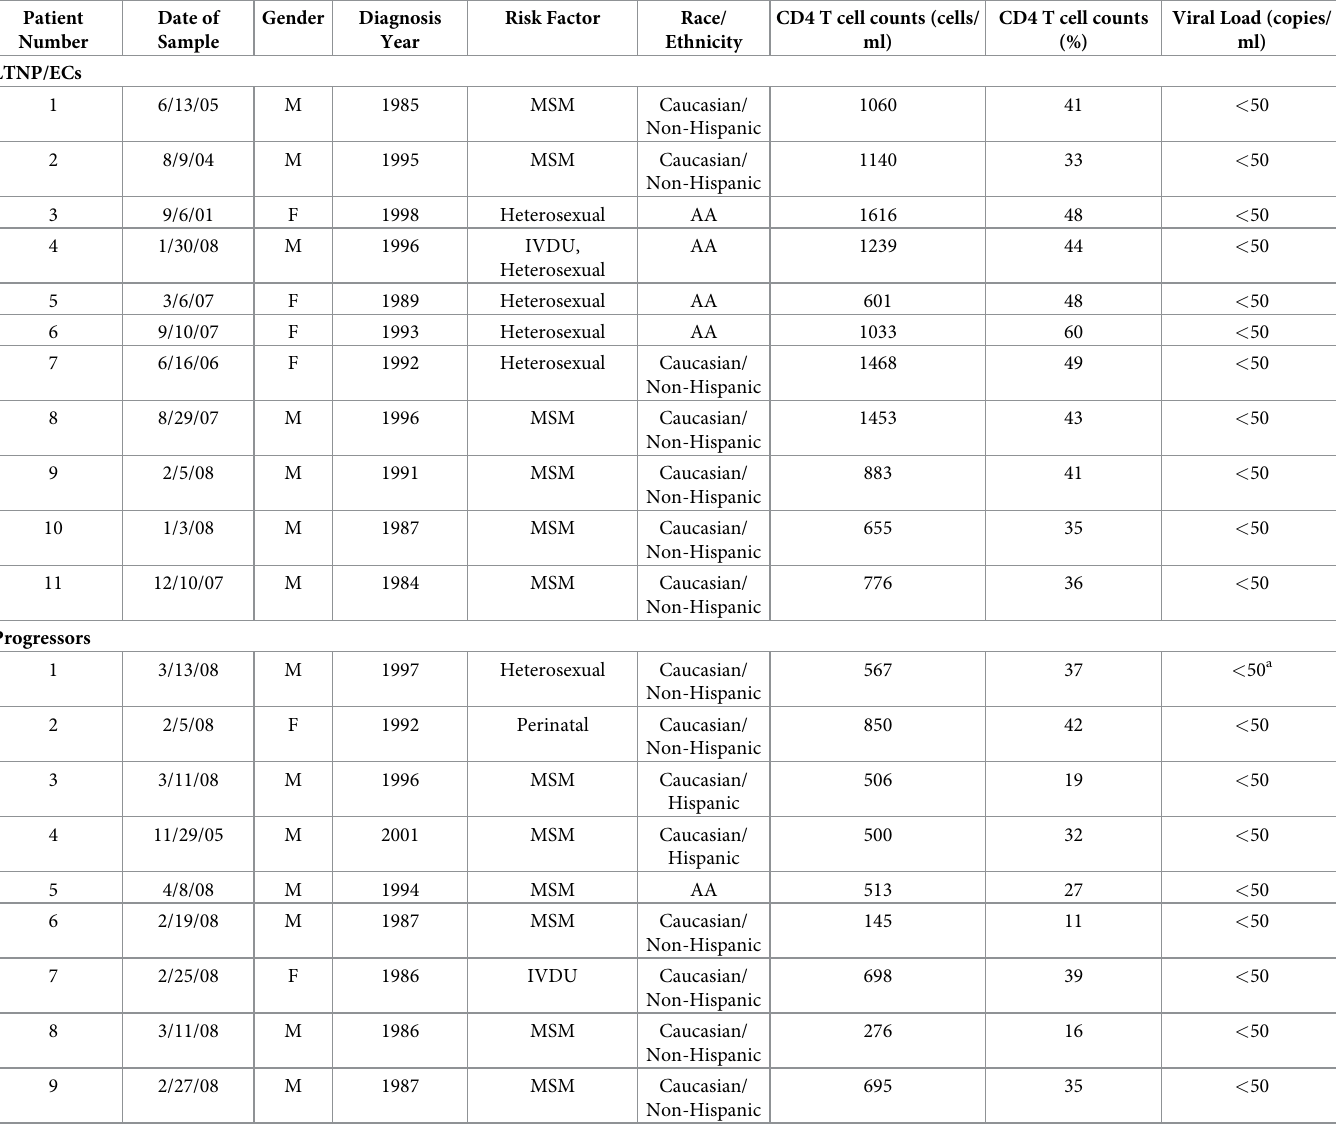
Table 1. Characteristics of HIV-infected LTNP/ECs and